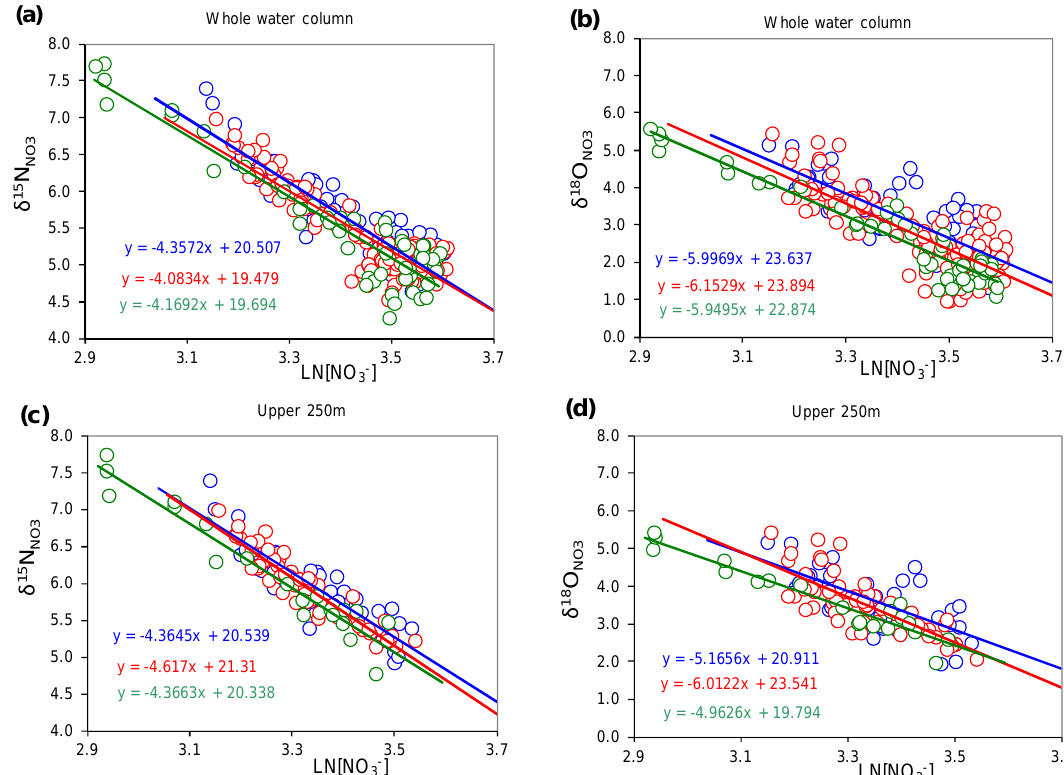
Figure 4. Regressions of δ 15 N (left) and δ 18 O (right) vs. LN[NO − plateau stations; red circles: meander stations; green circles: Polar Front and north of Polar Front stations.